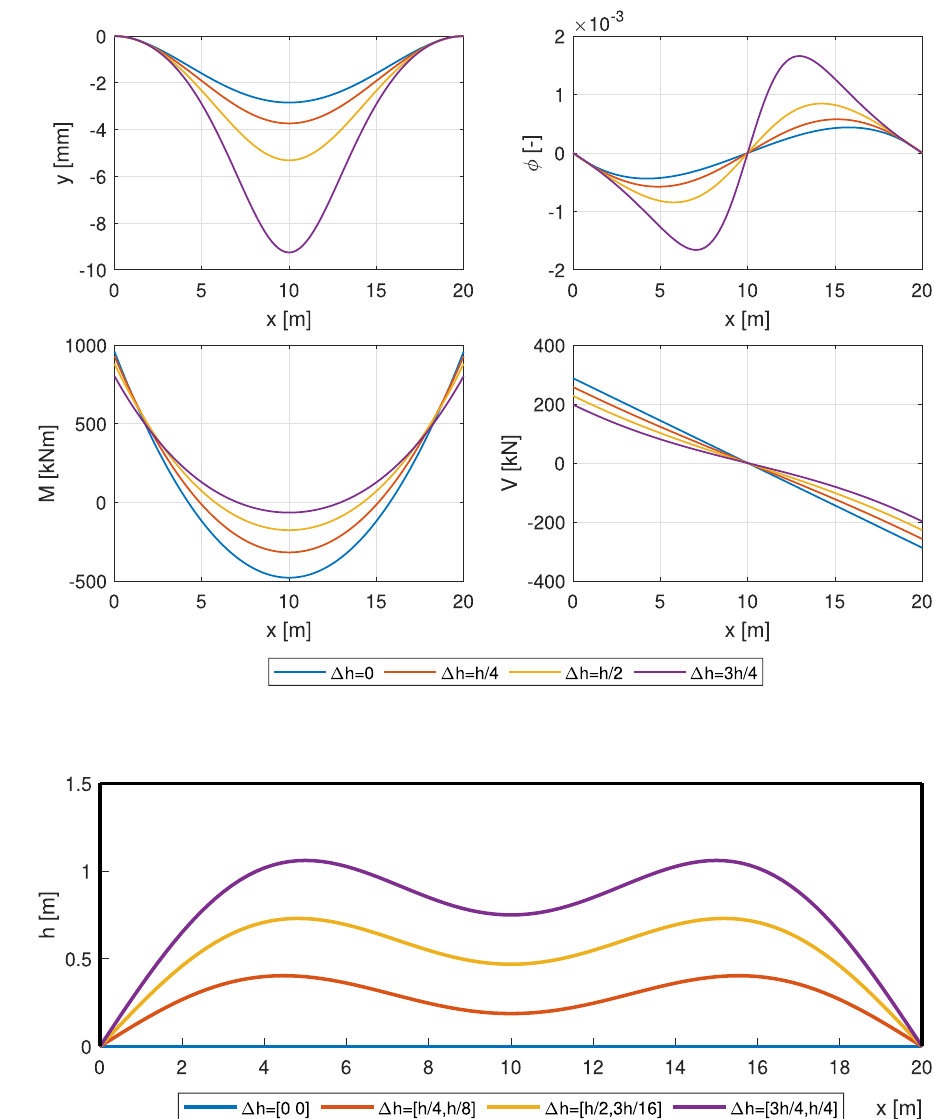
Fig. 4 Comparison among the internal actions and compli- ance parameters (deflection and rotation) with the different imposed maximum emptying values defined in Fig. 3 on a one lobe dog-bone beam